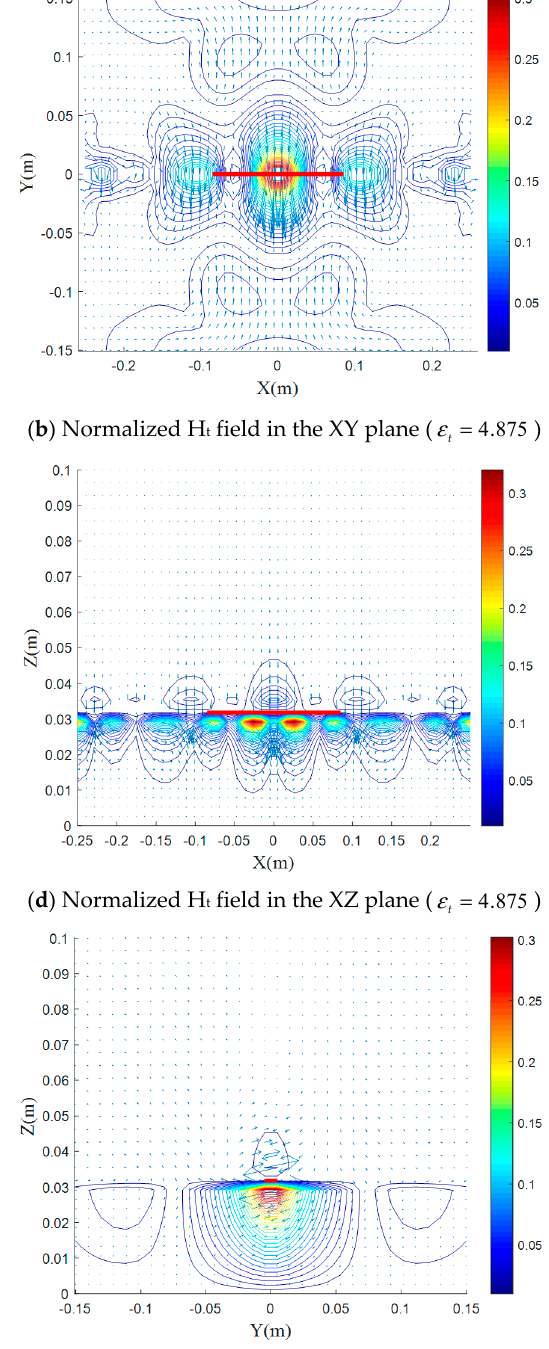
ε with 253 . = ε , 1 = μ and 1 = μ in the z t z t